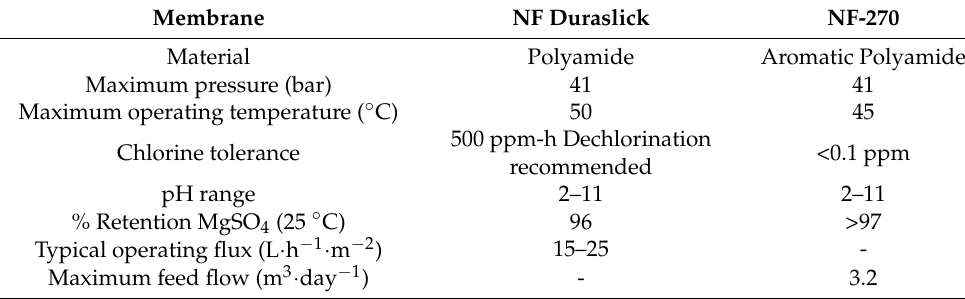
Table 2. Characteristics of the NF membranes.